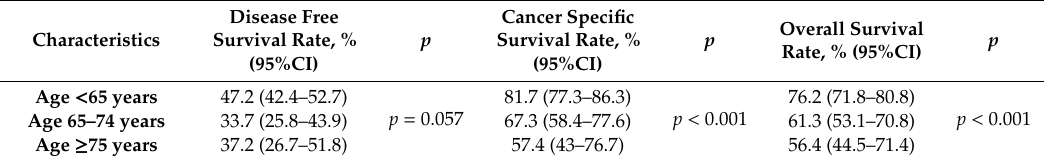
Table 3. Three-year disease-free survival, cancer-specific survival and overall survival rates (univariate analysis).